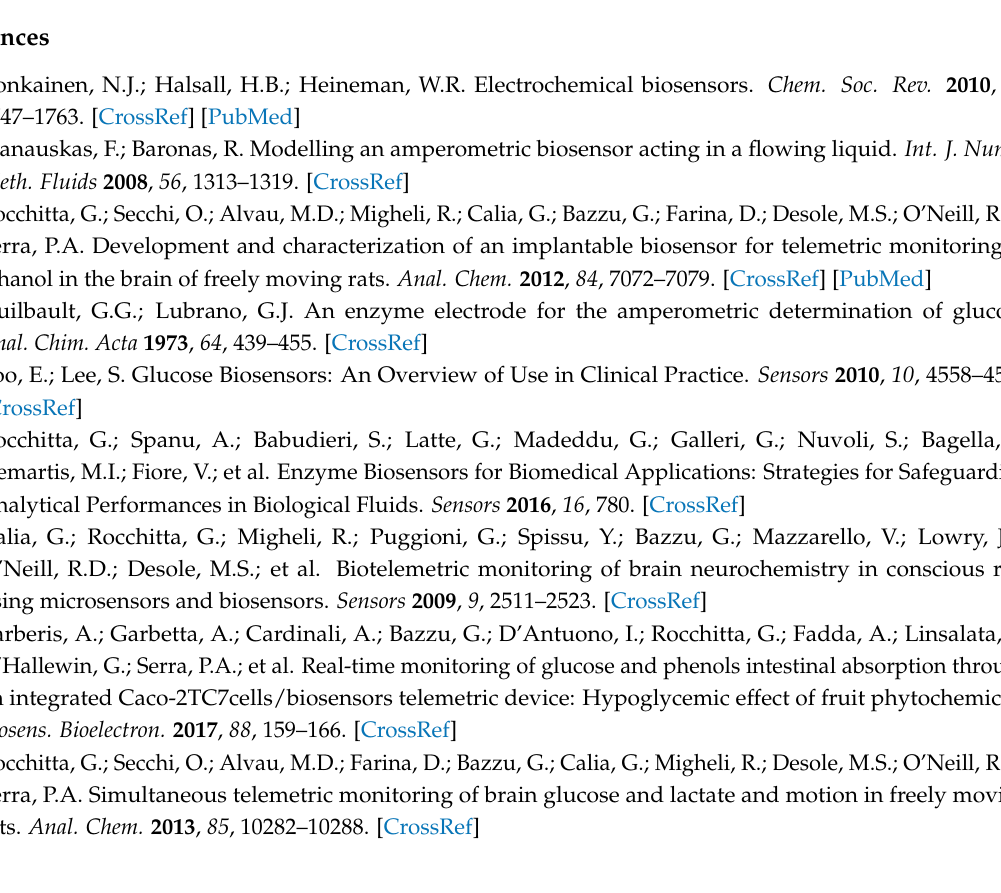
422/s1, Figure S1: Bar chart describing the variations of VMAX (Panel A, white bars), KM (Panel B, light gray bars) and LRS (Panel C, dark gray bars) of GB1 design Ptc/PPD/[PEI(0.5%)-GOx] 5 /PU(5%) in the defined range of 120 days. Values are expressed as mean ± SEM. *p < 0.01 vs. Day 1, Figure S2: Bar chart describing the variations of VMAX (Panel A, white bars), KM (Panel B, light gray bars) and LRS (Panel C, dark gray bars) of GB2 design Ptc/PPD/[PEI(0.5%)-GOx] 5 /GTA(1%)-BSA (2%) in the defined range of 120 days. Values are expressed as mean ± SEM. *p < 0.01 vs. Day 1, Figure S3: Bar chart describing the variations of VMAX (Panel A, white bars), KM (Panel B, light gray bars) and LRS (Panel C, dark gray bars) of LB1 design Ptc/PPD/[PEI(0.5%)-LOx] 5 /GTA(1%)-BSA (2%) in the defined range of 120 days. Values are expressed as mean ± SEM. *p < 0.01 vs. Day 1, Figure S4: Bar chart describing the variations of VMAX (Panel A, white bars), KM (Panel B, light gray bars) and LRS (Panel C, dark gray bars) of LB2 design Ptc/PPD/[PEI(0.5%)-LOx] 5 /GTA(1%)-BSA (2%) in the defined range of 120 days. Values are expressed as mean ± SEM. *p < 0.01 vs. Day